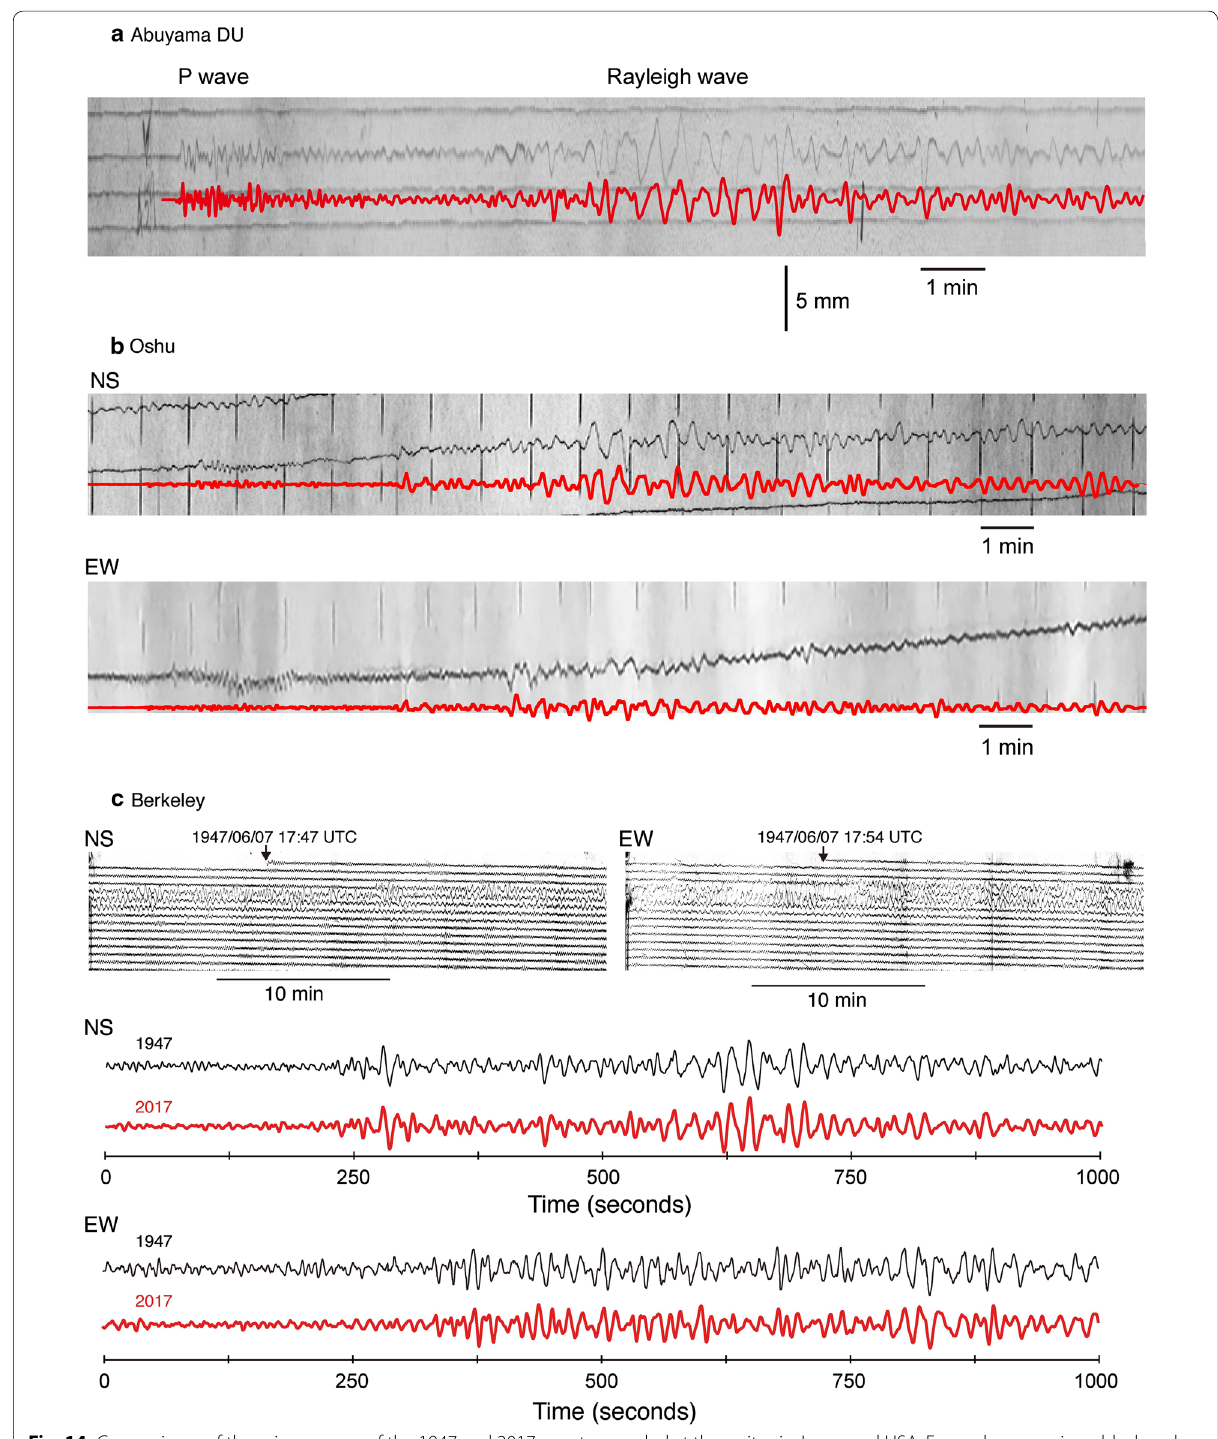
Fig. 14 Comparisons of the seismograms of the 1947 and 2017 events recorded at three sites in Japan and USA. For each comparison, black and red show seismograms of the 1947 and 2017 events, respectively. a Abuyama, western Japan, vertical (down–up) component. b Oshu, northeastern Japan, horizontal components. c Berkeley, California, USA, horizontal